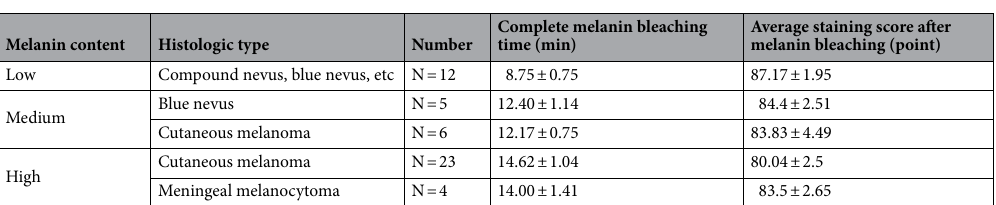
Table 3. Time required for complete melanin bleaching of 50 pathological sections with melanin in 1% TCCA